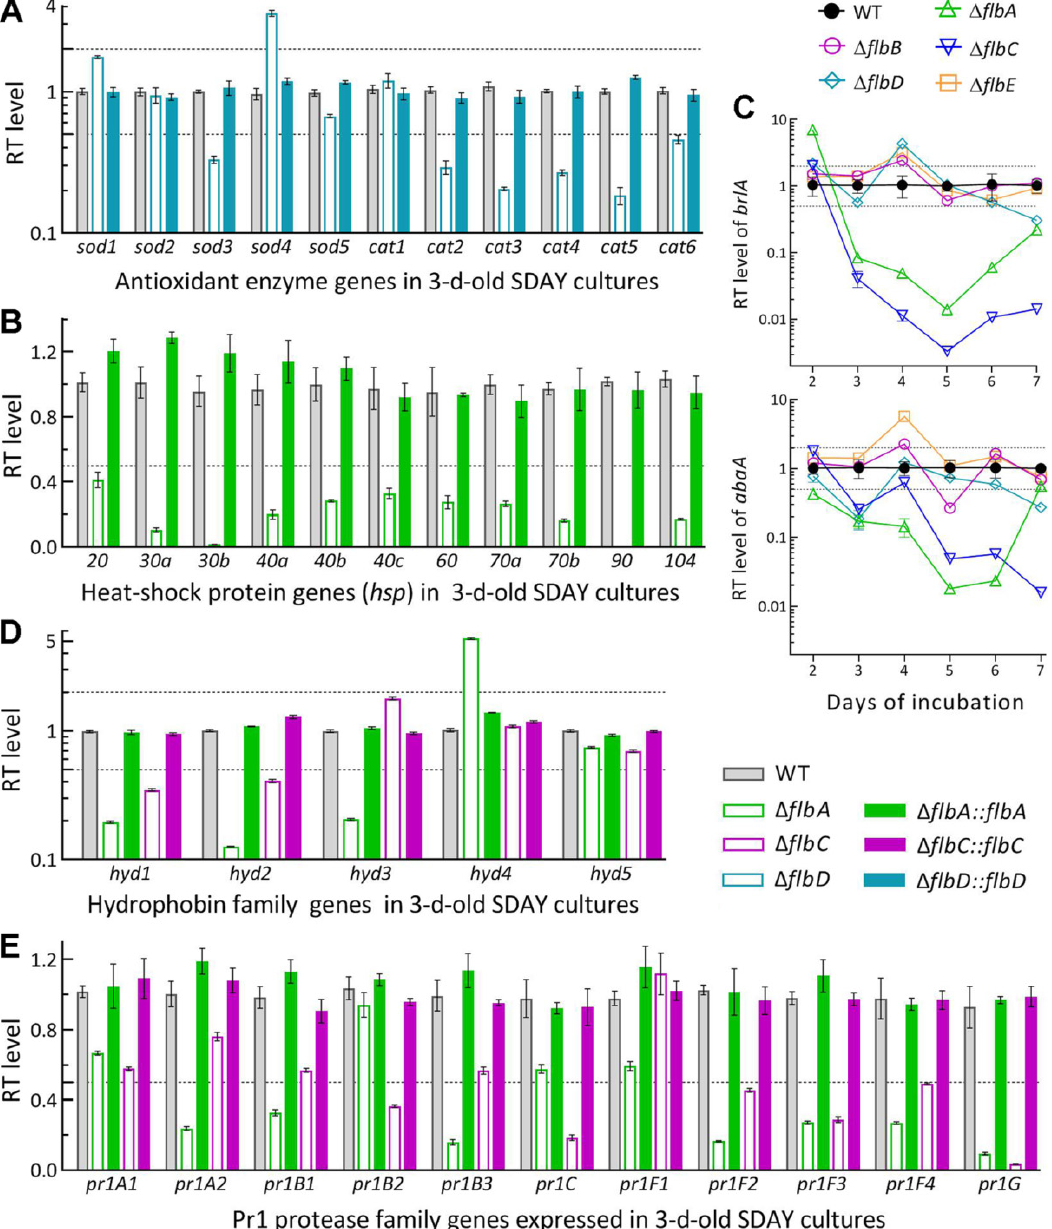
Figure 6. Relative transcript (RT) levels of clustered genes associated with phenotypes of the flb mutants with respect to the WT standard in B. bassiana . The tested cDNA samples were derived from the SDAY cultures initiated by spreading 100 μ L aliquots of a 10 7 conidia/mL suspension and incubated for 3 d ( A , B , D , E ) or 2–7 d ( C ) at the optimal regime of 25 ° C and L:D 12:12. The lower and/or upper dashed lines denote significant levels of one-fold down- and upregulation, respectively. Error bars: SDs of the means from three independent cDNA samples examined by qPCR analysis.